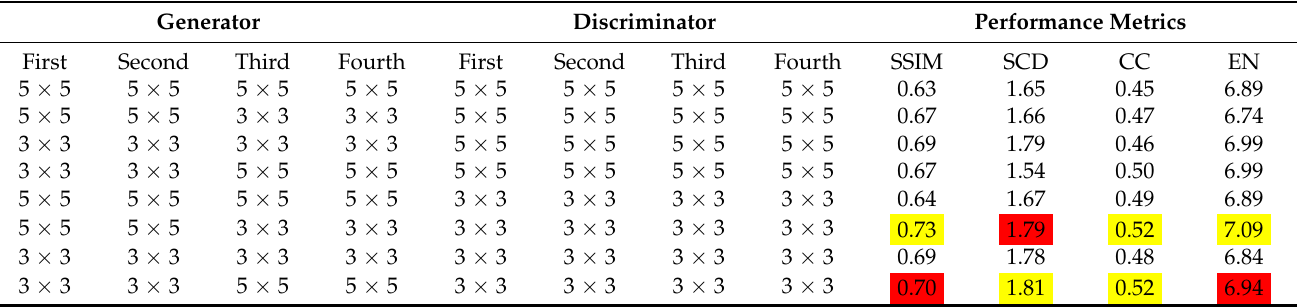
Table 1. Quantization results for the selection of 3 × 3 and 5 × 5 filters in DDGANSE on the TNO dataset (the best value is marked in yellow, and the second-best value is marked in red).